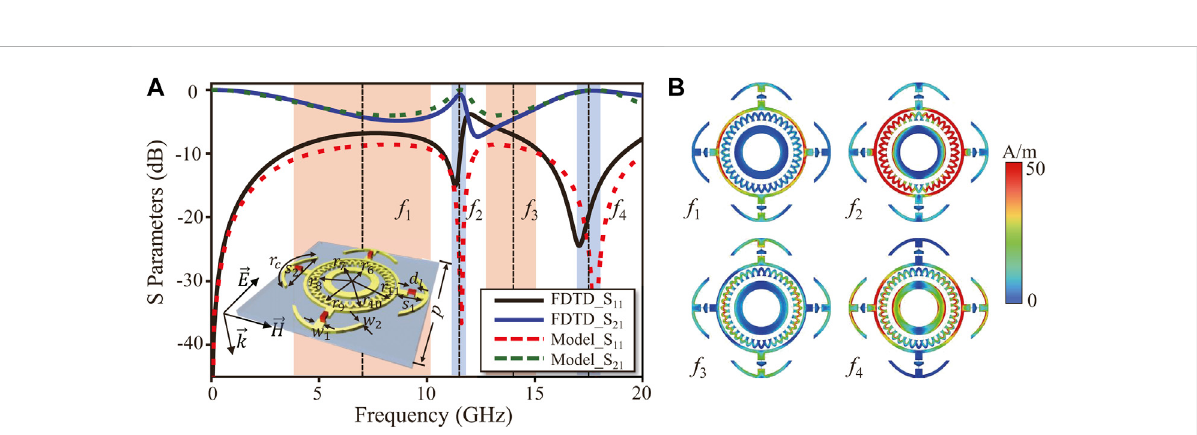
Simulation results of the resistive layer (A) S-parameters of the resistive layer calculated by full-wave simulation (solid curves) and equivalent circuit model (dashed curves). (B) Surface current distribution on the resistive layer.